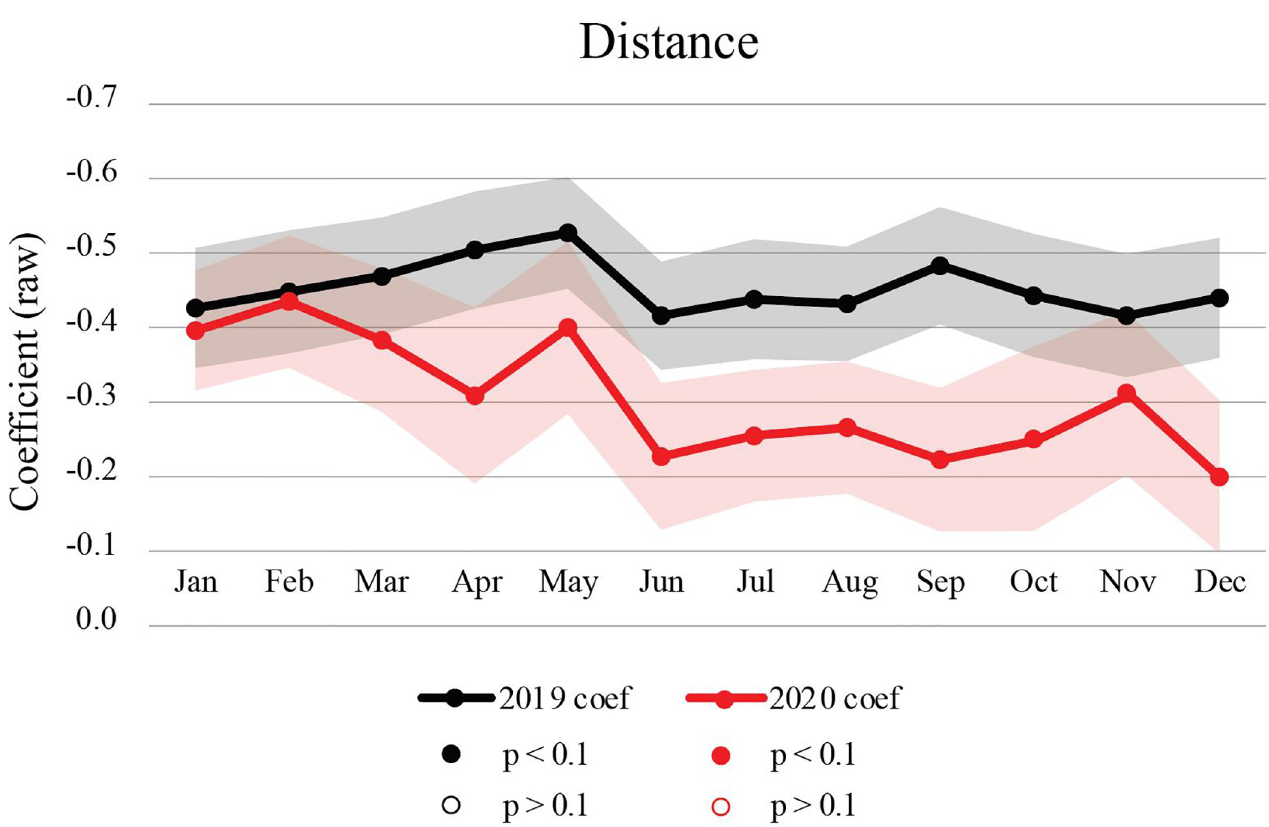
Fig 5. Estimated preferences towards distance from origin CBG to destination cluster, describing 2019 and 2020 raw distance coefficients.